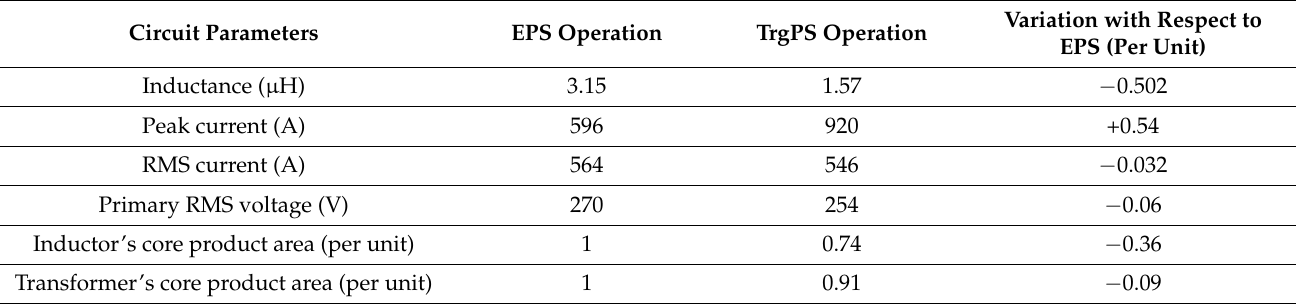
Table 4. Circuit parameter variation with respect to optimal EPS operating mode.